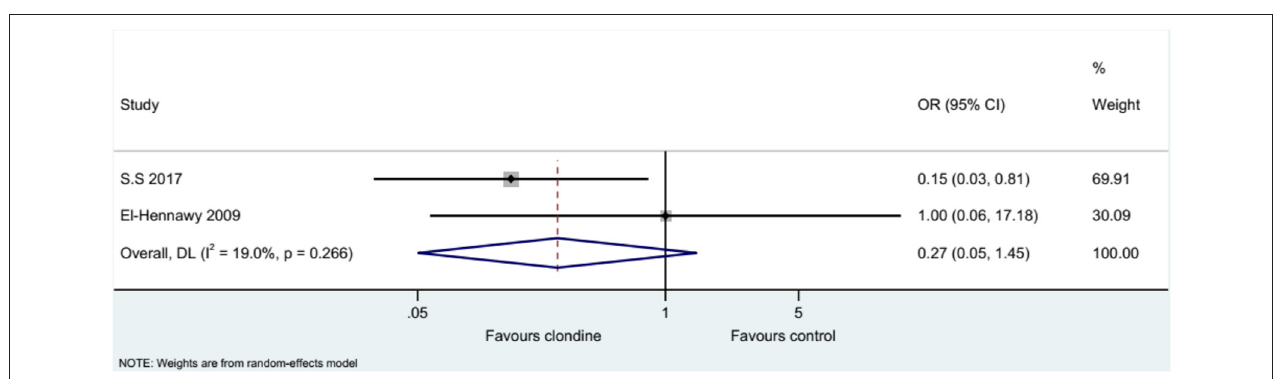
FIGURE 8 | Pain score (categorical